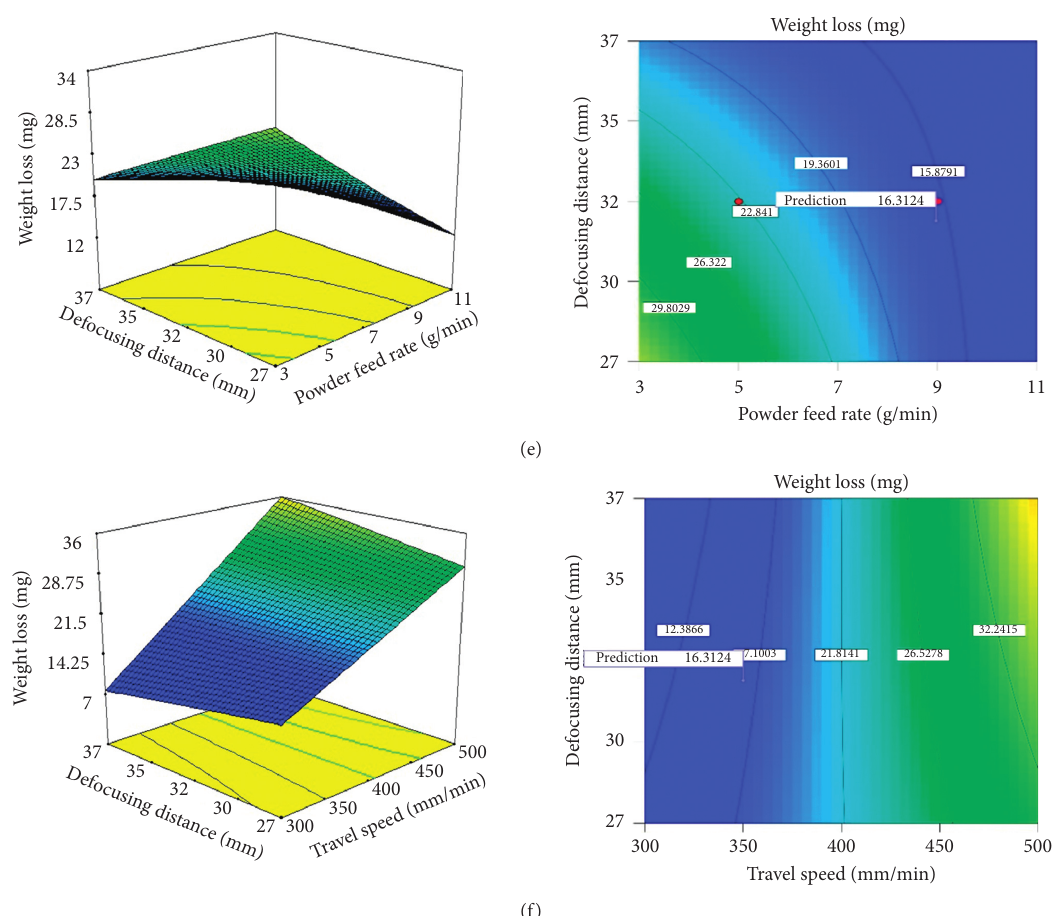
Figure 7: Response surface graphs and contour plots. The interaction between (a) laser power and powder feed rate, (b) laser power and travel speed, (c) laser power and defocusing distance, (d) powder feed rate and travel speed, (e) powder feed rate and defocusing distance, and (f) travel speed and defocusing distance is